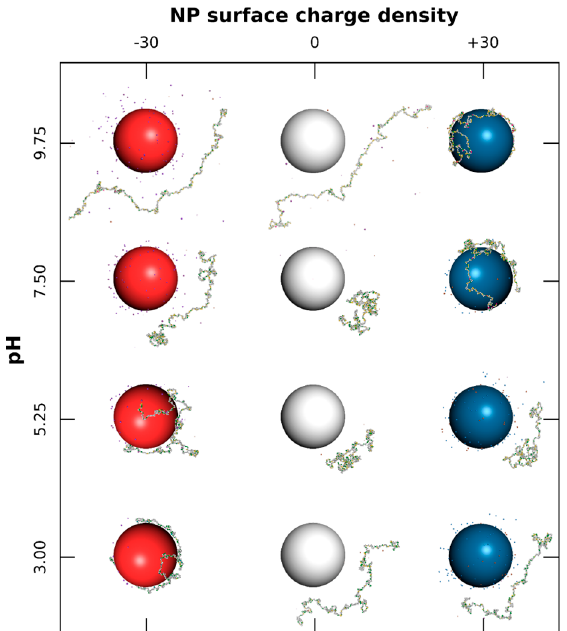
Figure 1. Monte Carlo simulations of polypeptide (PP) chain and nanoparticle (NP) surrounded by monovalent counterions. Negative, neutral, and positive NPs (100 Å radius) are represented by red, white, and blue spheres, respectively. AAs have green (positive), grey (neutral), and yellow (negative) colors. Cases with NP surface charge densities equal to − 30, 0, and +30 mC/m 2 , and for pH variation from 3.00 to 9.75 are considered.